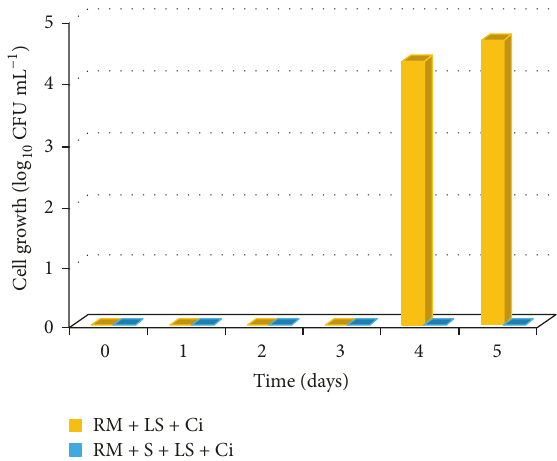
Figure 1: Monitoring the synergistic effect at 4 ∘ C. RM = raw milk; Ci = cinnamon essential oil at 3 𝜇 gmL −1 ; LS = activation of the lactoperoxidase system with 30 mg L −1 of sodium percarbonate and 14 mgL −1 of sodium